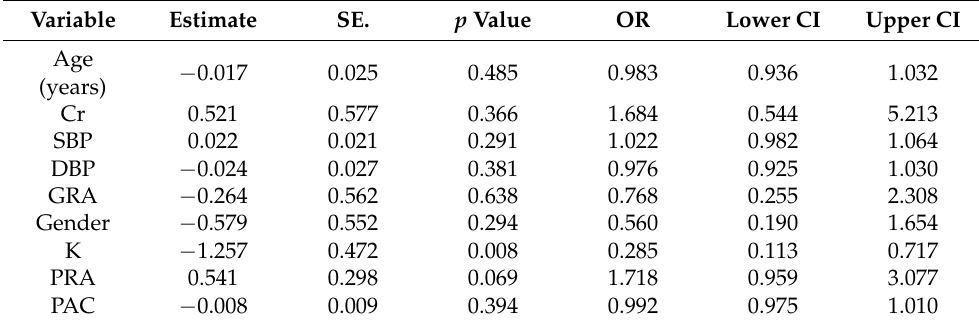
Table 3. The association of pre-operative variables predicting hypertension-remission ( n = 97) in unilateral PA patients by logistic regression.